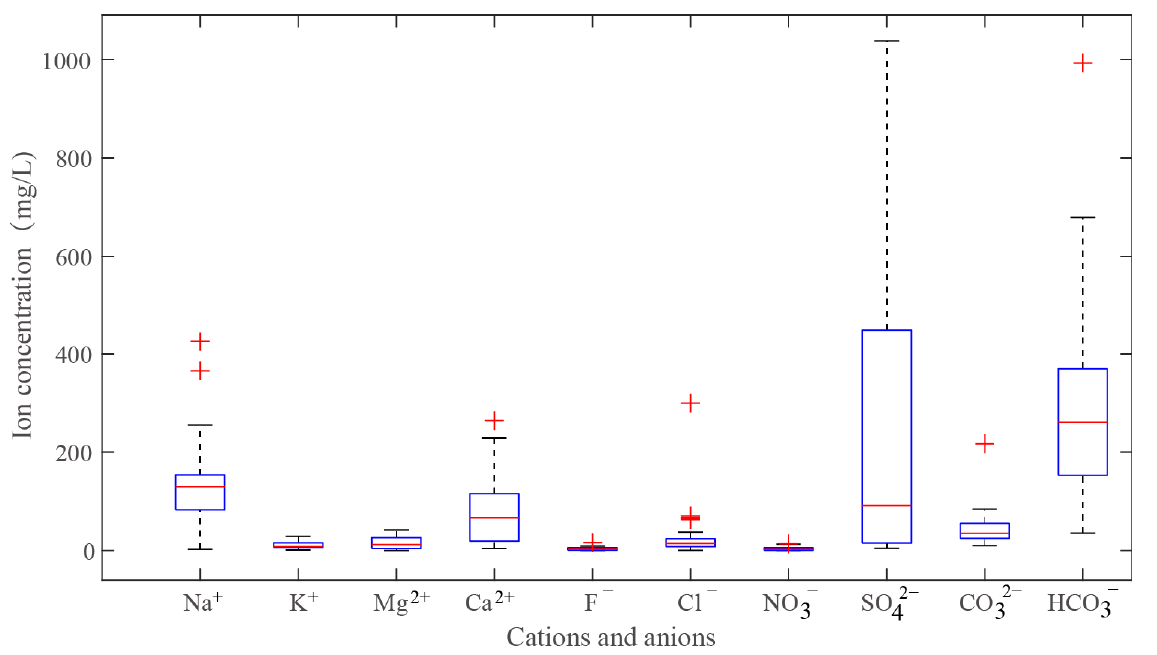
Figure 4. Box plots are used to describe the concentration of cations and anions. The width of the box reflects how volatile the data are. The flatter the box, the more concentrated the data. The symbol “+” represents the data outliers, which represents the ion enrichment in this paper.